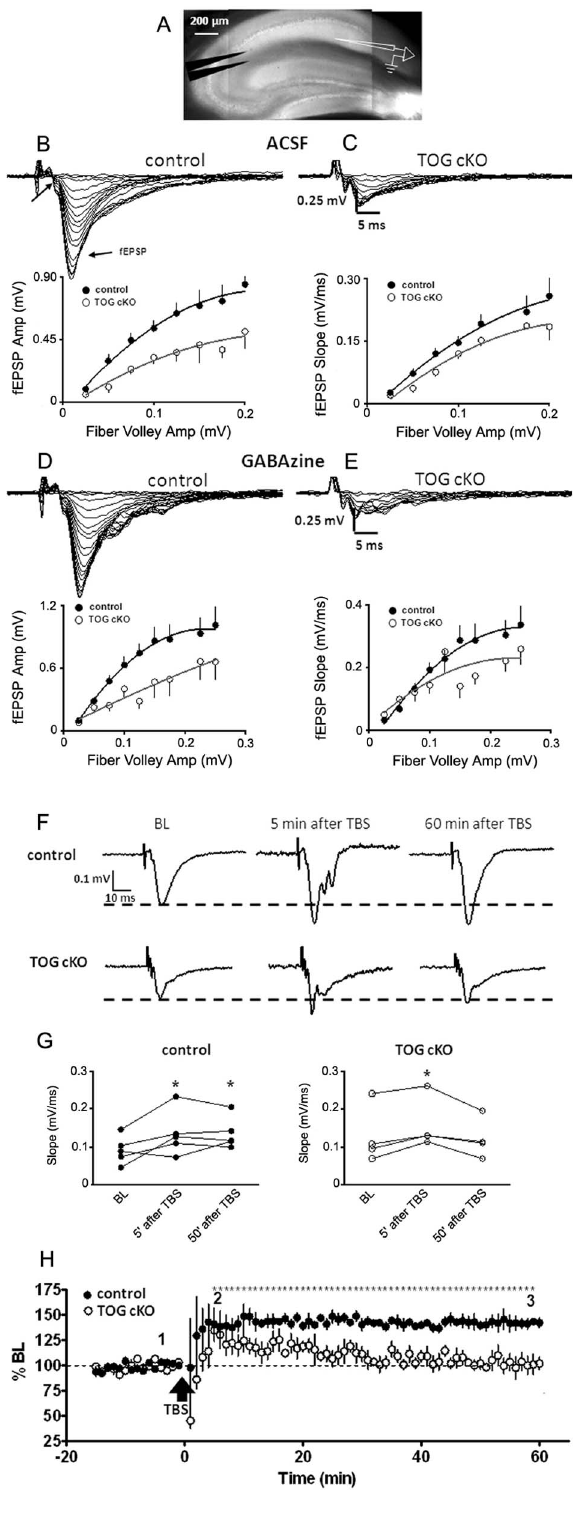
Figure 4. fEPSPs and LTP in CA1 of control and TOG cKO hippocampal brain slices. A. Infrared differential interference contrast micrograph of a hippocampal slice showing bipolar tungsten electrode (left) and glass recording electrode (right) placement. B – C. Electrical recording of field responses from control (B) and TOG cKO (C) slices at various stimuli intensities. Presynaptic fiber volley and field excitatory postsynaptic potential (fEPSP) are marked by arrows.